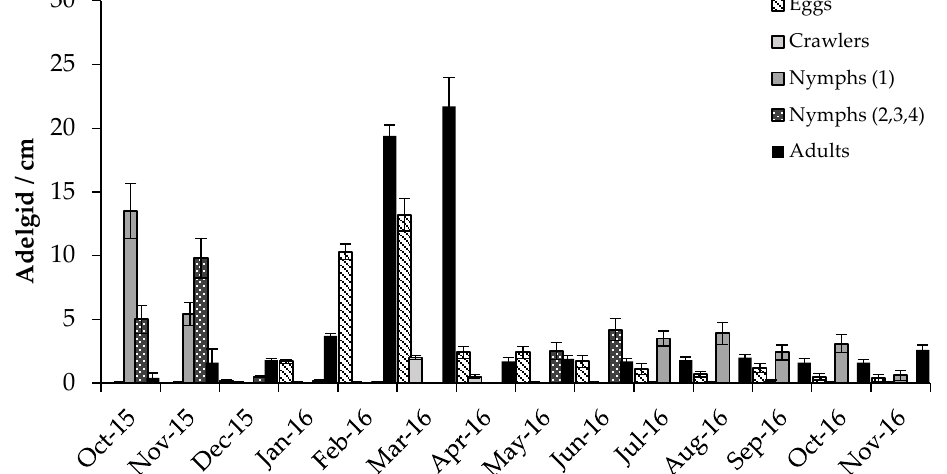
Figure 2. Mean number (±SE) of Adelges tsugae by lifestage collected from Tsuga heterophylla in Tacoma, WA, USA (October 2015 – November 2016).